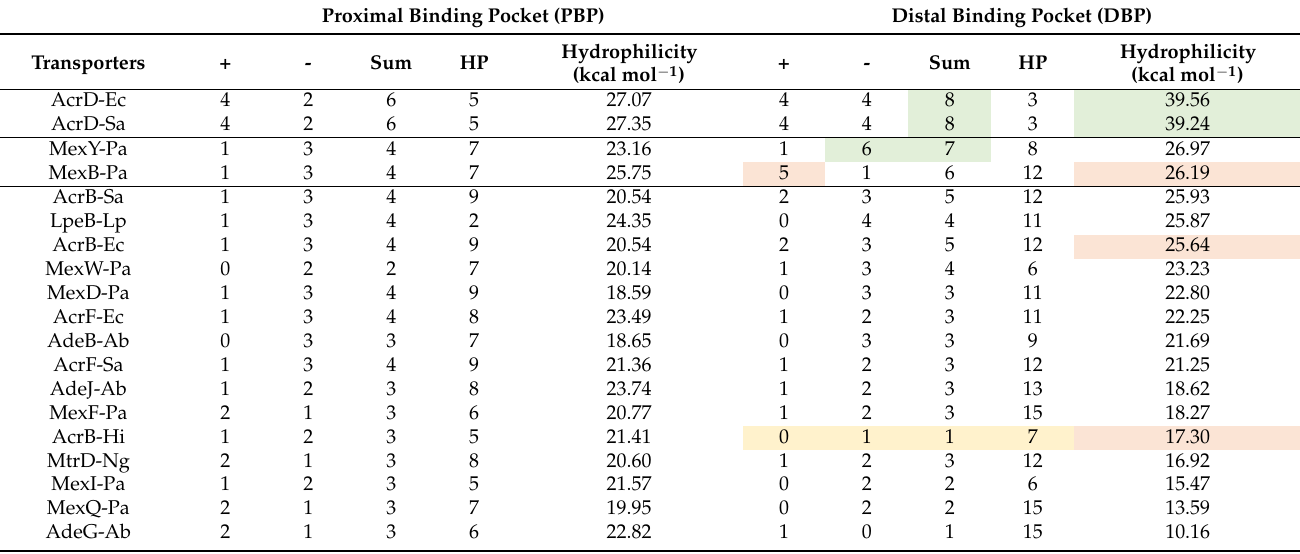
Colors: green, positive contribution to aminoglycoside recognition; orange, negative contribution or difference explaining aminoglycoside non-recognition; yellow, AcrB-Hi’s low charged and hydrophobic residue count (and hydrophilicity, orange), possibly explaining lower substrate export efficiency compared to AcrB-Ec (including the significantly low bile salt MICs). Hydrophobicity based on [93]. Abbrevia- tions and symbols: number of positively charged residues (+), negatively charged residues (-) and hydrophobic residues (HP). Definitions: positively charged, K and R; negatively charged, D and E; hydrophobic, I, L, F, V, C and M